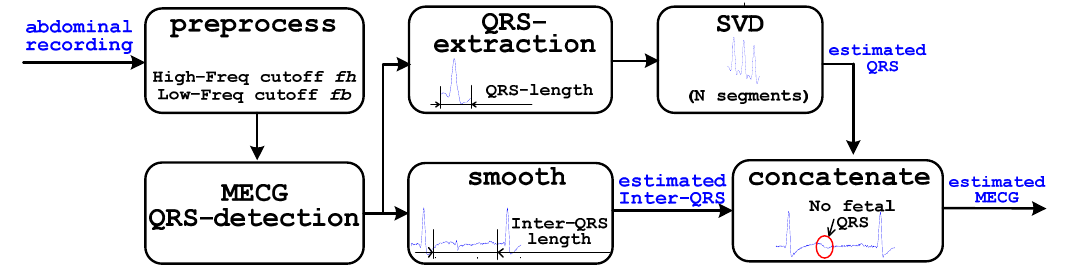
Figure 2. Block diagram of the SWSVD scheme.